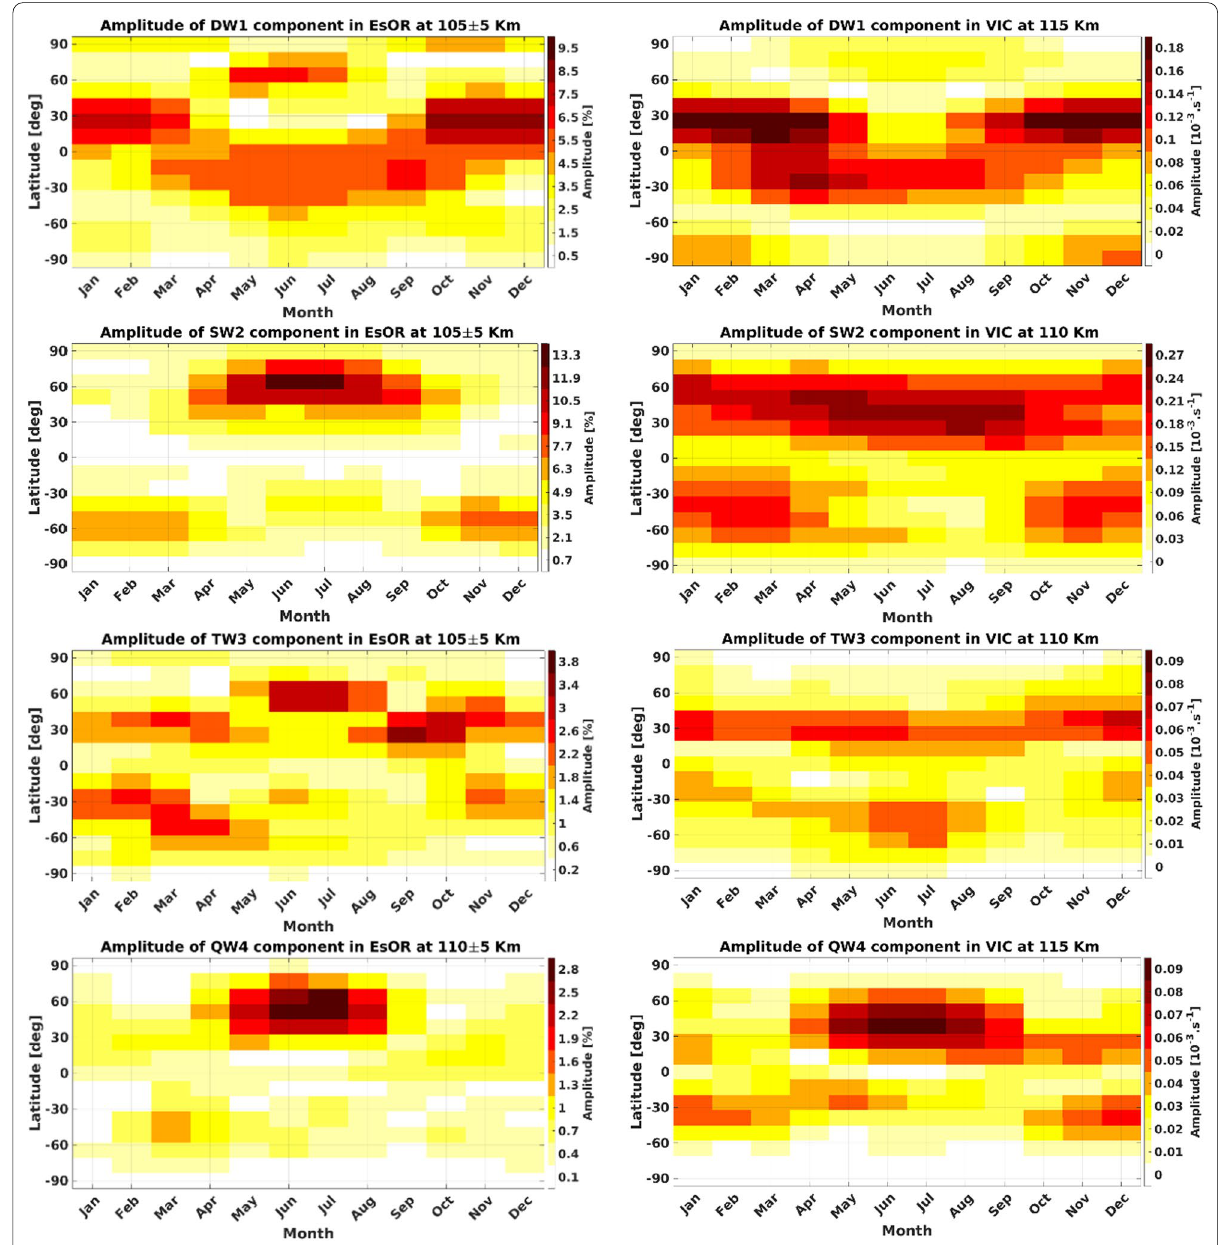
Fig. 6 Month‑to‑month amplitude variation of migrating components of tides in EsOR (left column) and VIC (right